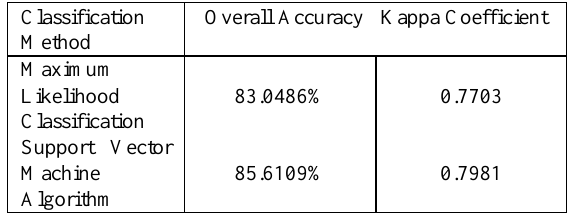
Table 2. Classifier accuracies based on test data for MLC and